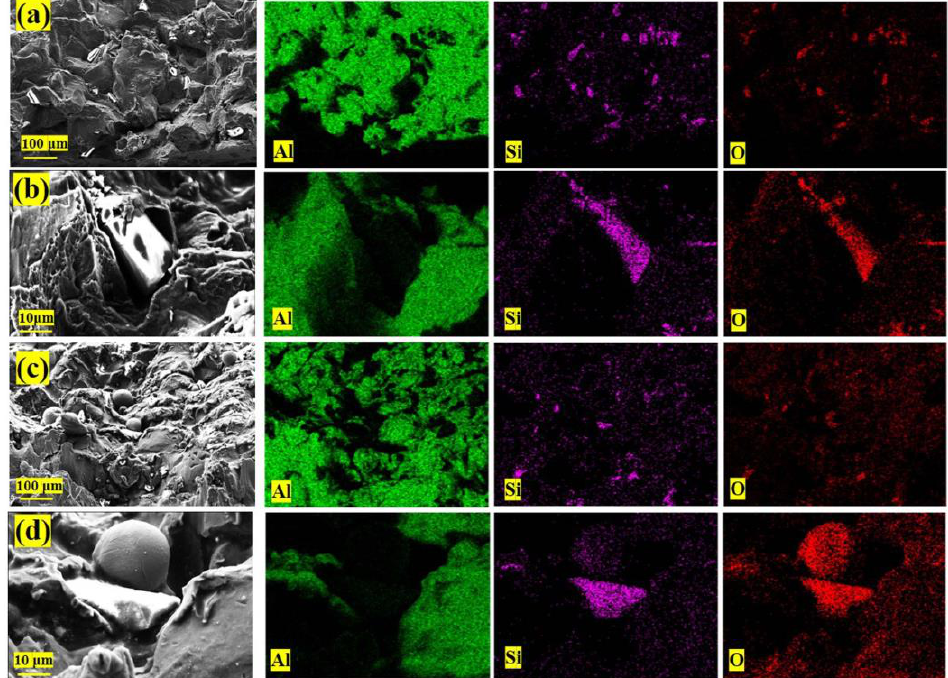
Figure 10. SEM and EDS analysis images of the composite coating. ( a ) Coated cross-section; ( b ) closed space locked CBF; ( c ) coated surface; ( d ) CBF clad with thermos-softened Al.